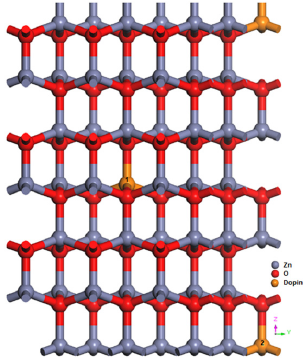
Figure 1. A 3 × 3 × 3 supercell model for Al/Ga ‐ doped ZnO. Figure 1. A 3 ˆ 3 ˆ 3 supercell model for Al/Ga-doped